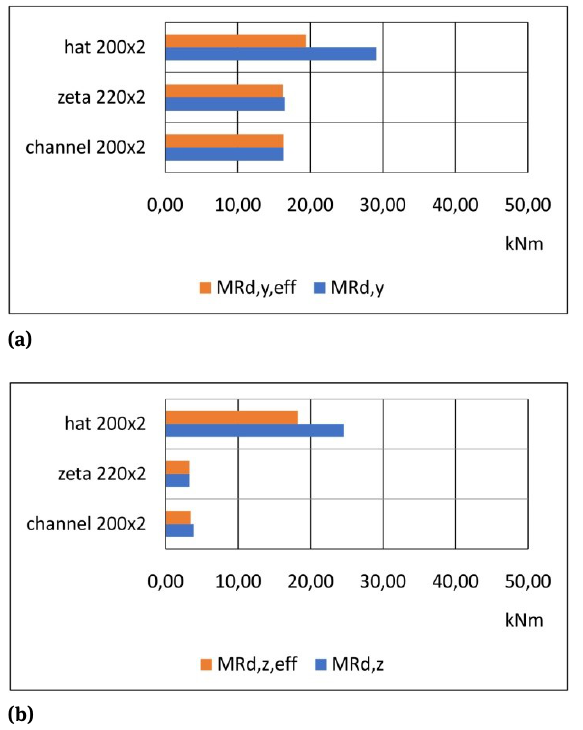
Figure 4: Resistance of cross-section in bending